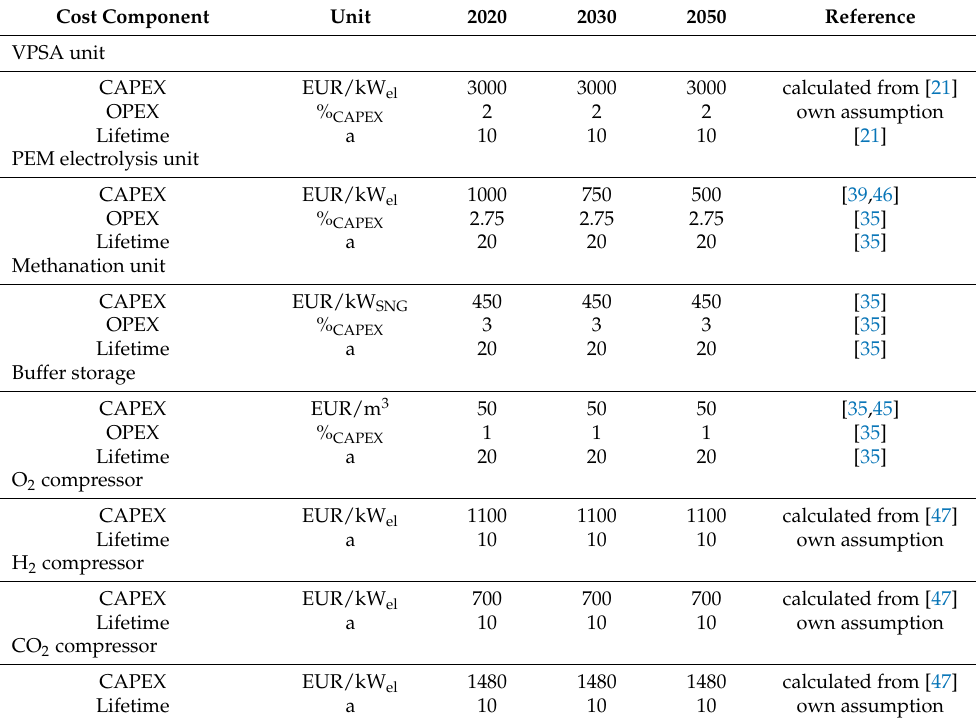
Table 3. Specific equipment costs for the years 2020, 2030, and